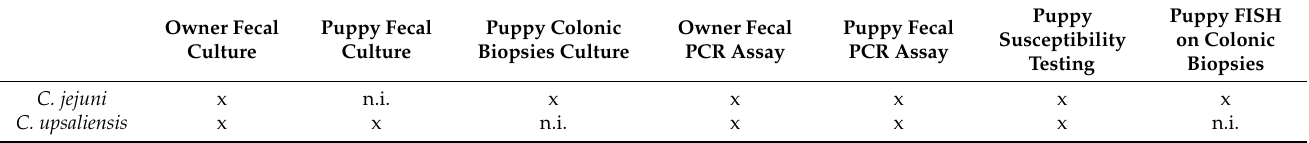
Table 4. Results of fecal culture, PCR assay, susceptibility testing and FISH of both the puppy and the owner (where